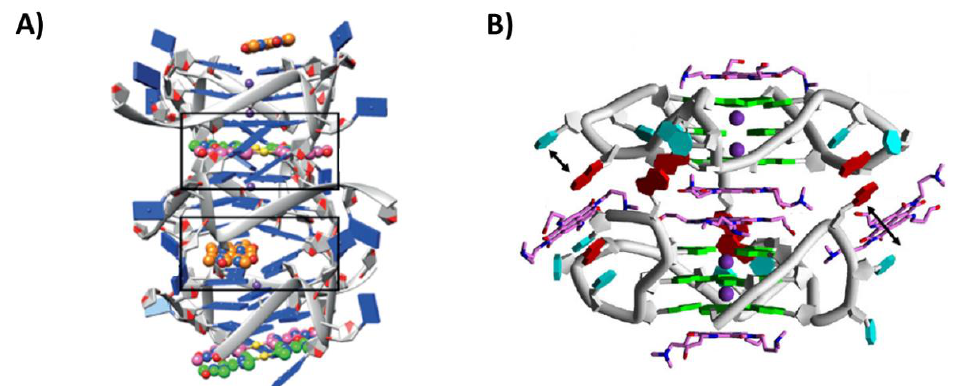
Figure 4. ( A ) Crystal structure of the complex between the unimolecular parallel G-quadruplex h-tel23 of sequence d[TAGGG(TTAGGG) 3 ] and [Au(9-methylcaffein-8-ylidene) 2 ] + [44]. ( B ) Crystal structure of the complex between the unimolecular parallel G-quadruplex h-tel23 of sequence d[TAGGG(TTAGGG) 3 ] and NDI-1 [47]. G-quadruplex units are 5 (cid:48) -5 (cid:48) stacked. Adapted with permission from refs. [44,47], Copyright 2016 WILEY-VCH Verlag GmbH & Co. KGaA, Weinheim and Copyright 2008 Elsevier Ltd. Two additional different tetrasubstituted NDI derivatives with propyl (BMSG-SH3) or butyl (BMSG-SH4) side chains terminating with N -methyl-piperazine moieties